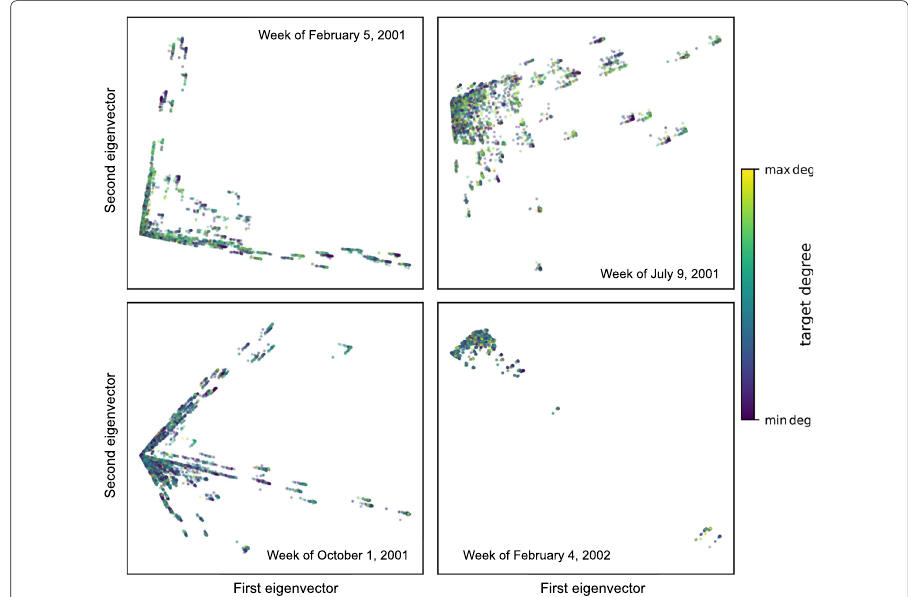
Fig. 14 NBED of select weekly-aggregated Enron graphs. Top left, top right, and bottom left correspond to non-anomalous weeks, according to Fig. 13. Bottom right corresponds to the anomalous week marked with a yellow circle in Fig. 13, labeled “1: Lay resigns from board”. In all four we see some of the patterns that were identified in Fig. 12 and “Visualization”